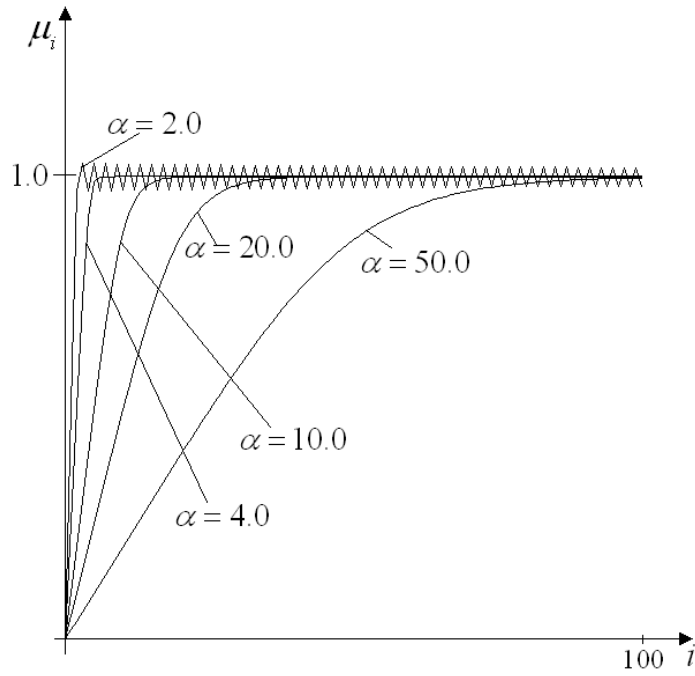
Figure A5. The constants µ i as a function of the index i ( i = 0,1,2, . . . ,100) for the same previously selected values of α